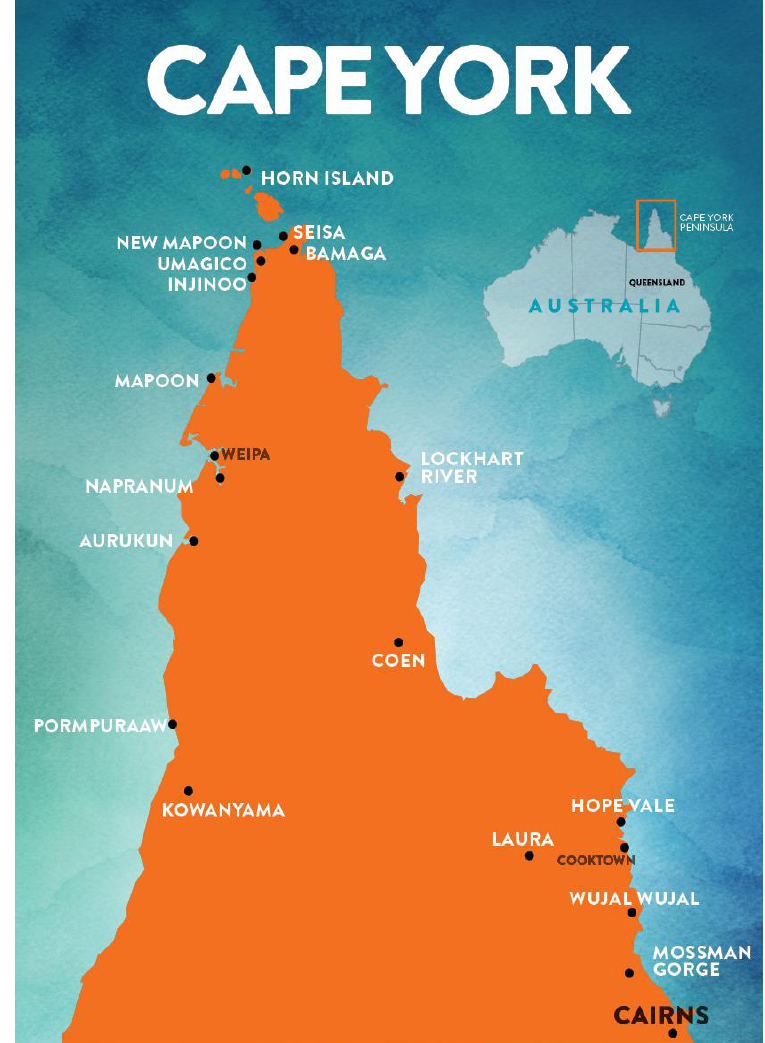
Figure 1. Map of Cape York Peninsula, North Queensland, Australia.